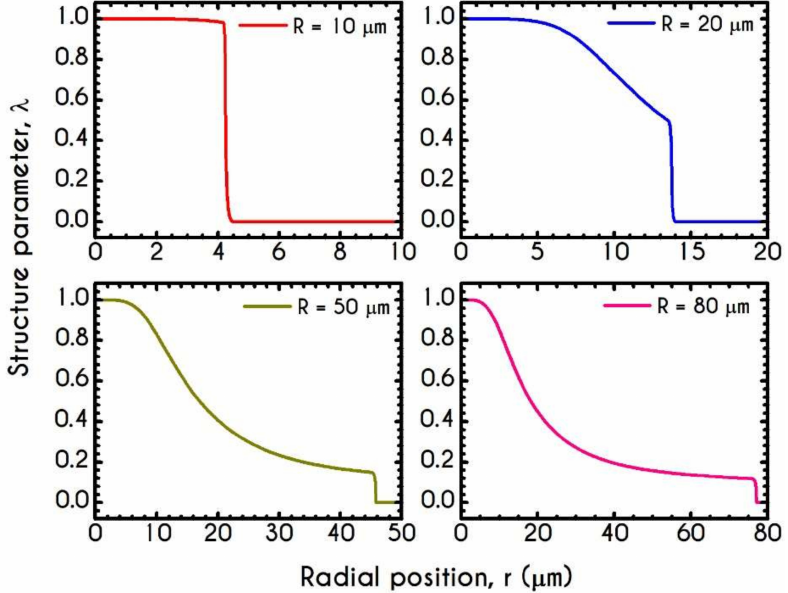
Figure 6. Distribution of the structure parameter λ along the radial position for tube radius equal to